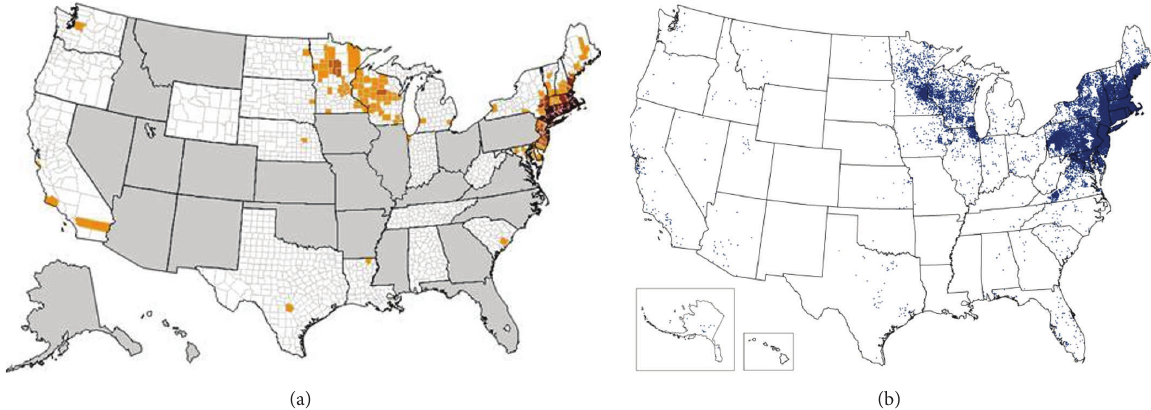
Figure 2: Geographic distribution of babesiosis and Lyme disease in the United States. (a) Reported cases of at least one case of babesiosis in 22 of the 27 different states that conducted surveillance: white = 0 cases; yellow = 1–5 cases; orange = 6–10 cases; brown = 11–20 cases; and dark brown > 20 cases. Babesiosis was not a reportable disease in the gray states, and health departments in those states did not notify CDC of cases [6]. (b) Reported cases of Lyme disease across the United States. Each blue dot represents a confirmed case